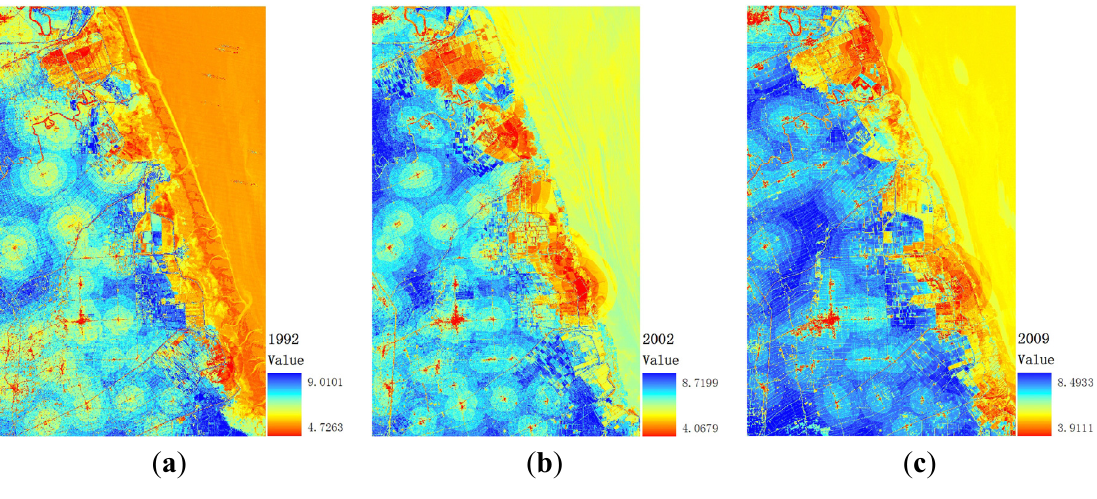
Figure 8. Results of ecological security evaluation over the wetland of Yancheng for three dates. ( a ) 1992; ( b ) 2002; ( c )